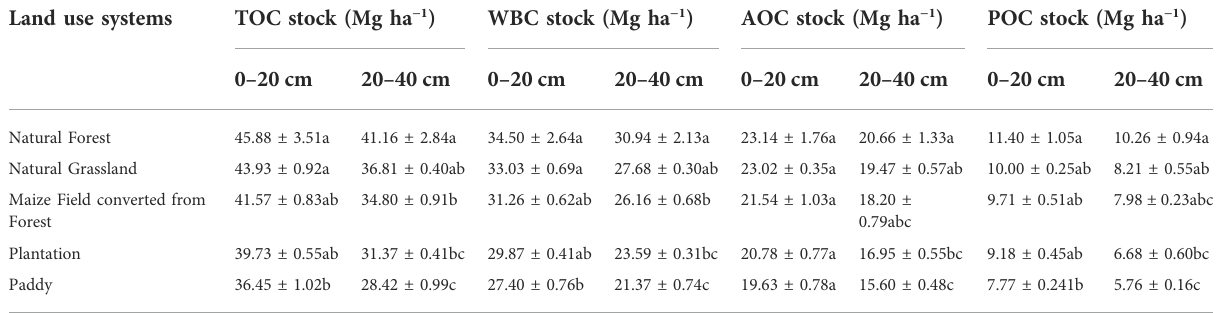
TABLE 3 Organic carbon stocks in surface and sub-surface layers under diverse land use systems.